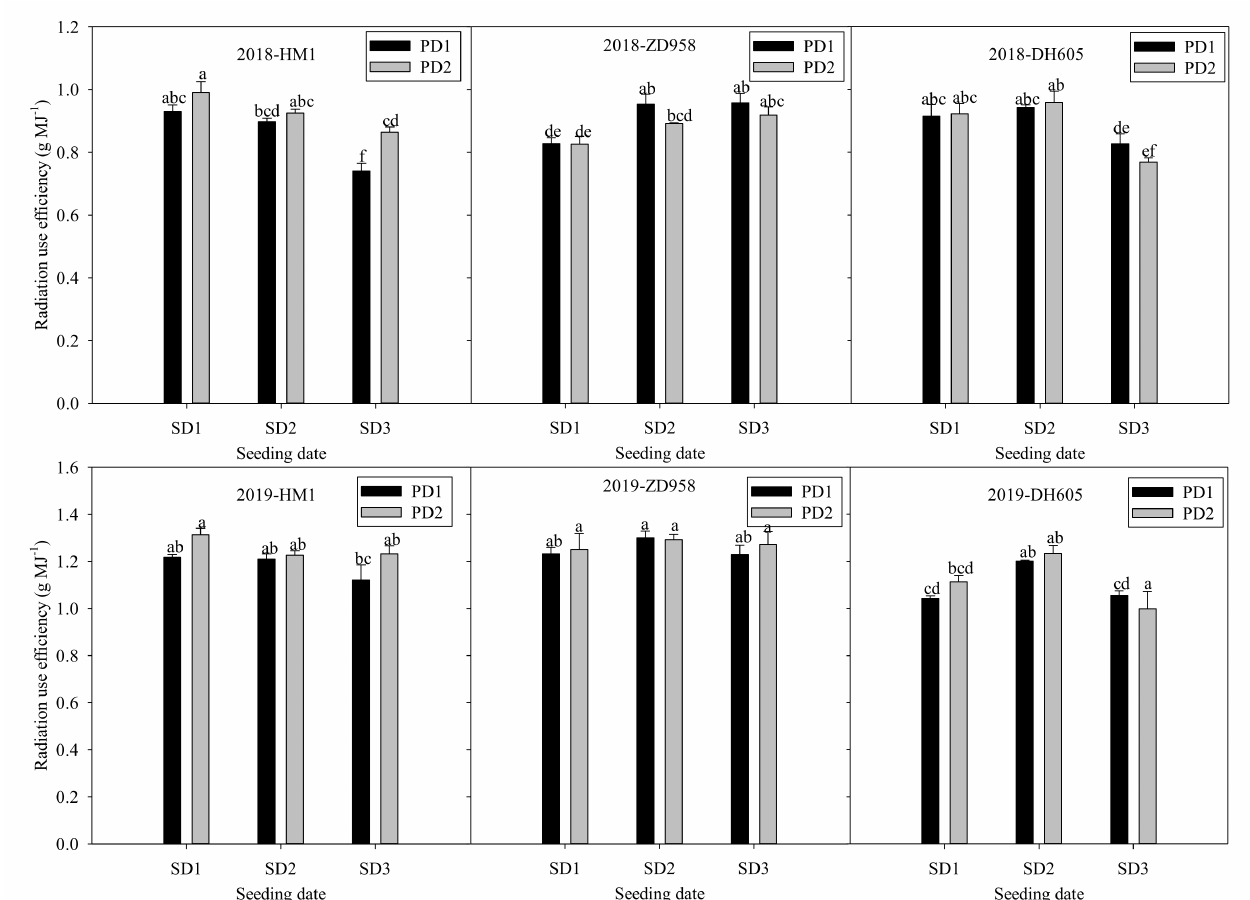
Figure 3. Effects of cultivar, sowing date and plant density on radiation use efficiency of summer maize. SD1, SD2, and SD3 represent the sowing dates of June 10, June 17, and June 24, respectively. PD1 and PD2 represent the plant densities of 6.75 × 10 4 plants ha − 1 and 8.25 × 10 4 plants ha − 1 , respectively. Different lowercase letters above the columns within one year indicate a significant difference at p <